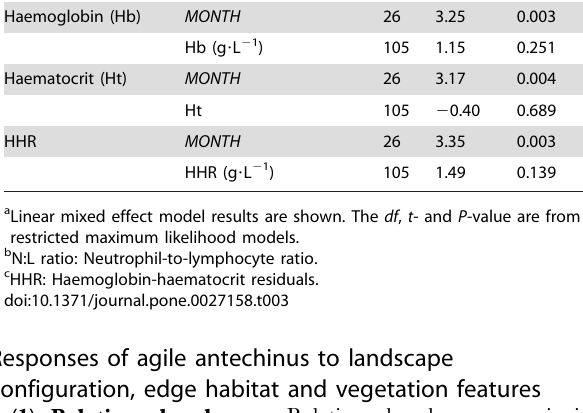
Table 6. Relationships between relative abundance and environmental variables for agile antechinus.